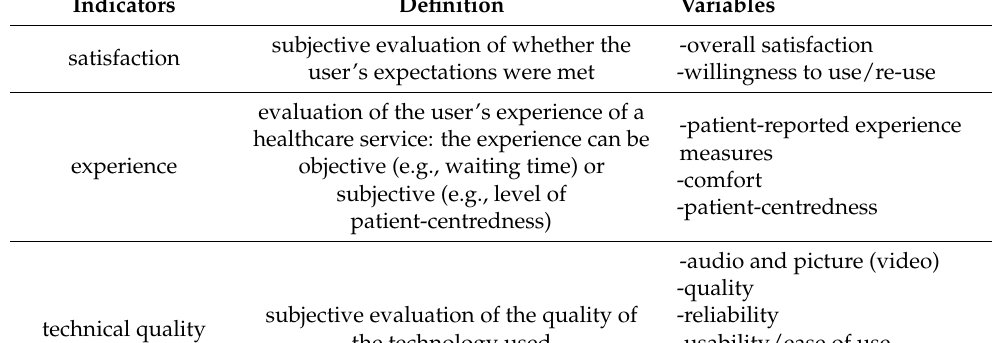
Table 1. List of indicators, definitions, and